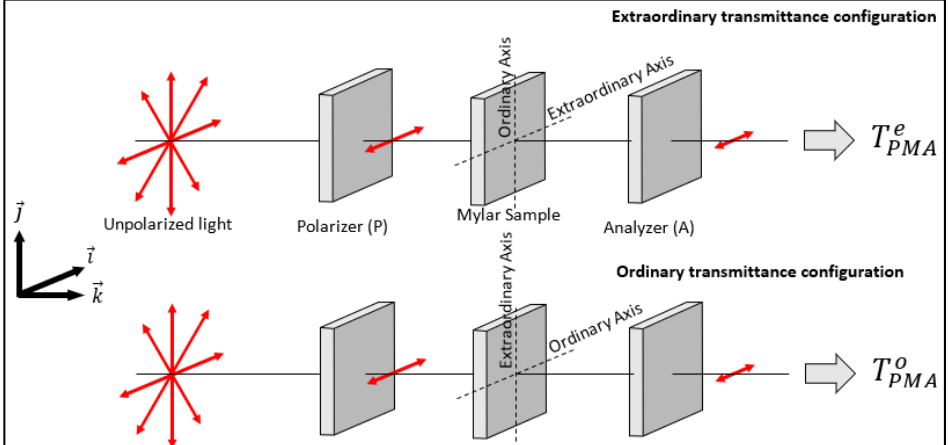
Figure 3. Experimental setup with the ordinary and extraordinary transmittance measurement configurations. The system Polarizer-Mylar-Analyzer (PMA) is placed in the sample compartment of the spectrophotometer.